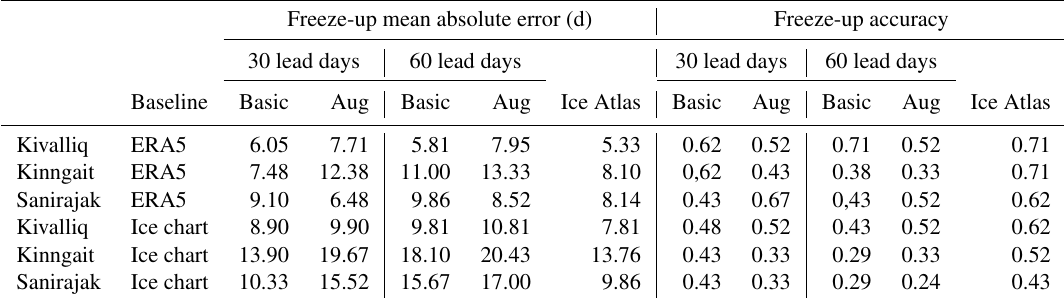
Table 2. Freeze-up mean absolute error and accuracy at selected sites using data from the CIS Ice Atlas, Basic, and Augmented (Aug) models at 30 and 60 lead days versus baseline observations derived from CIS regional ice charts and ERA5.